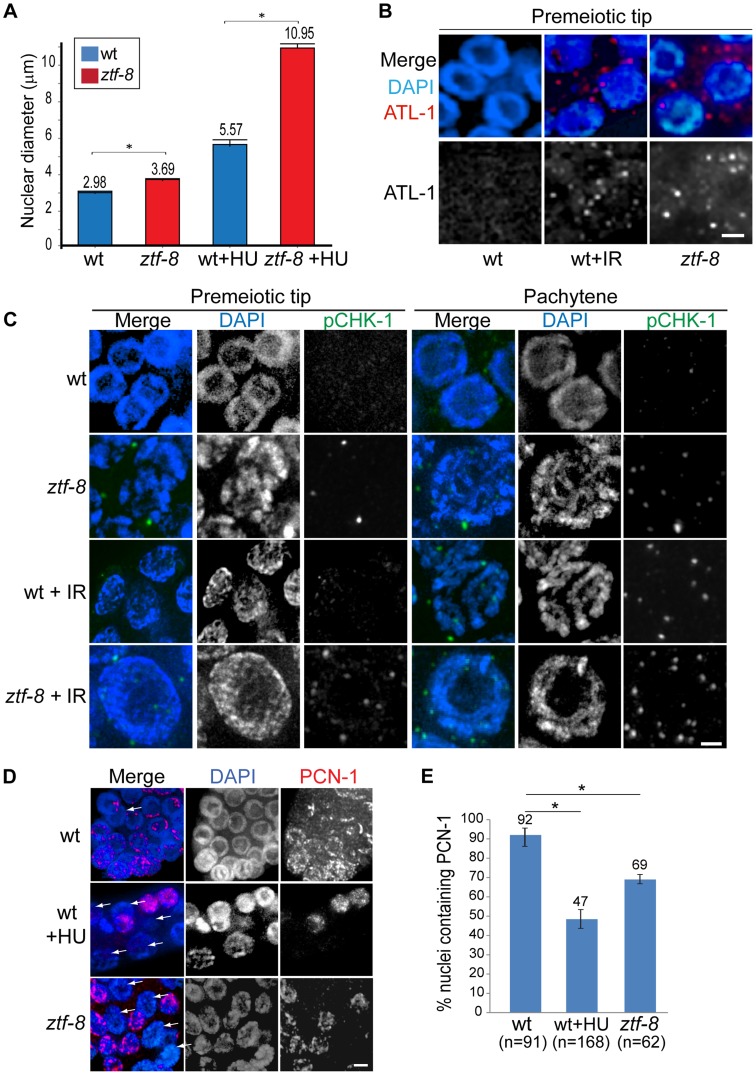
S-phase DNA damage checkpoint activation is intact in ztf-8 mutants.
A. ztf-8 mutants exhibit enlarged nuclear diameters at the premeiotic tip. Asterisks indicate statistical significance by the two-tailed Mann-Whitney test, 95% C.I., P<0.0001 without HU treatment and P<0.0001 in 20 mM HU containing NGM media. n = 178, 170, 80, 81 for wt, ztf-8, wt+HU, and ztf-8+HU, respectively. B. Immunolocalization of ATL-1 in premeiotic tip nuclei of germlines from IR or non-IR treated wild type worms and ztf-8 mutants. C. Immunostaining for phospho CHK-1 (pCHK-1) of germline nuclei at the indicated stages. Bar, 2 µm. D. 69% of mitotic germline nuclei in ztf-8 mutants exhibit PCN-1 signal, which marks nuclei in S-phase, compared to 93% of nuclei in wild type. Arrows indicate nuclei lacking PCN-1 signal. Wild type worms exposed to 5 mM HU were used as a control for S-phase arrest. Bar, 2 µm. E. Quantitation of the percentage of nuclei containing PCN-1 signal. Asterisks indicate statistical significance. P = 0.0002 for wild type and wild type+HU and P = 0.0088 for wild type and ztf-8 mutants. Statistical tests by the two-tailed Mann-Whitney test, 95% C.I.